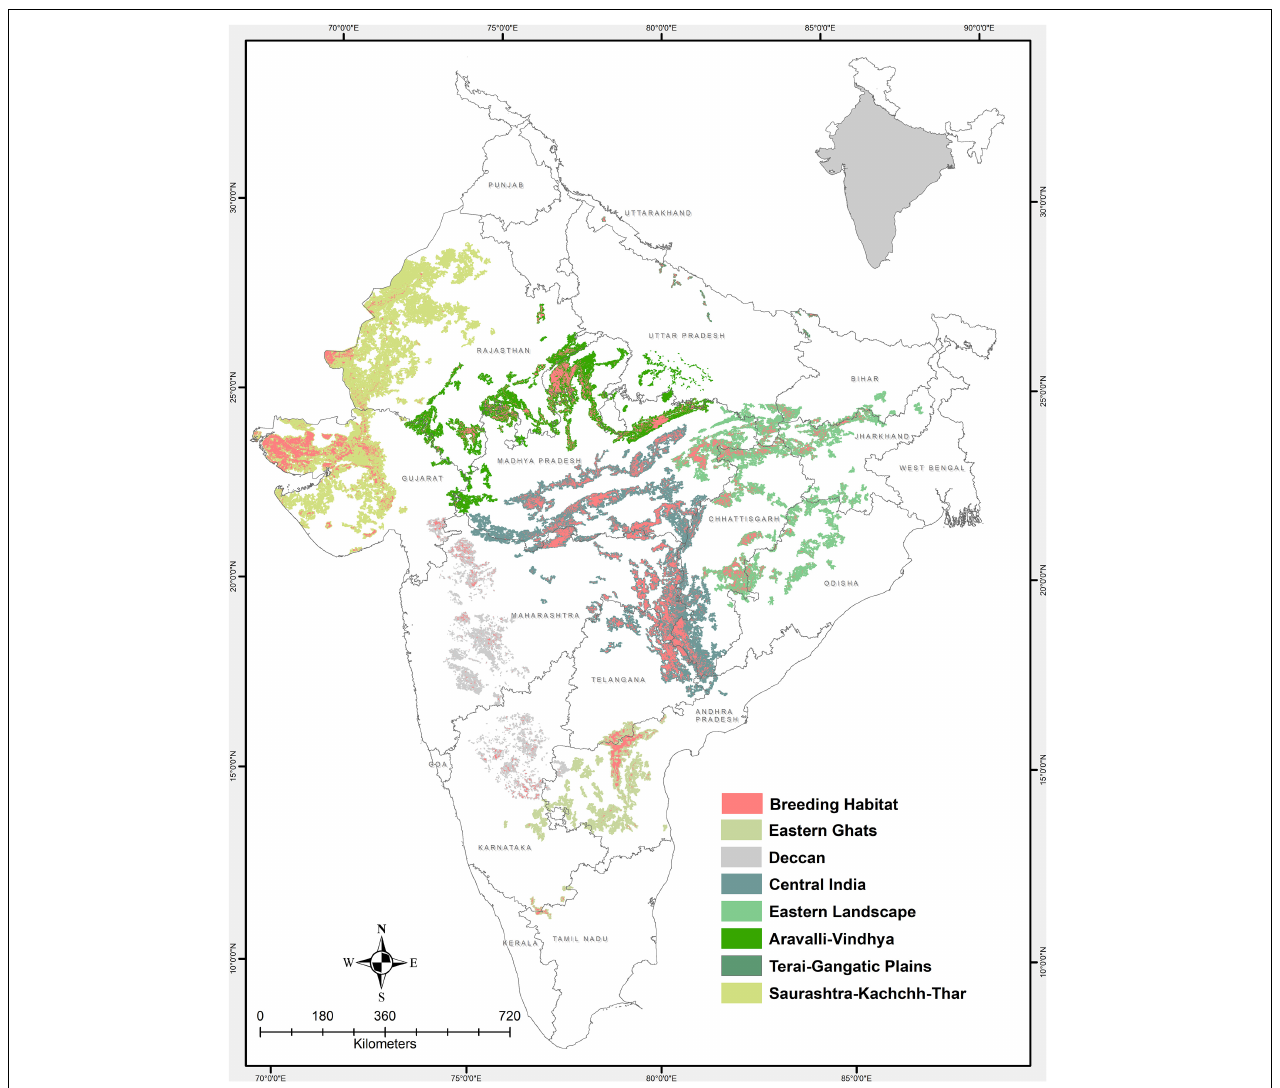
FIGURE 3 | Wolf-occupied landscapes and breeding habitats across India inferred from the MaxEnt models. MaxEnt, maximum entropy